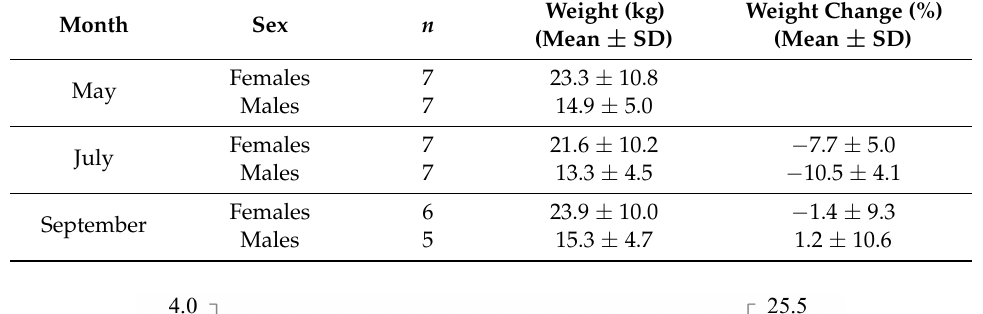
Table 1. Mean ( ± standard deviation (SD)) weight of F1 greater amberjack broodstock during the monitored reproductive period and mean ( ± SD) ratio of weight loss (%) at each sampling time versus the previous sampling.